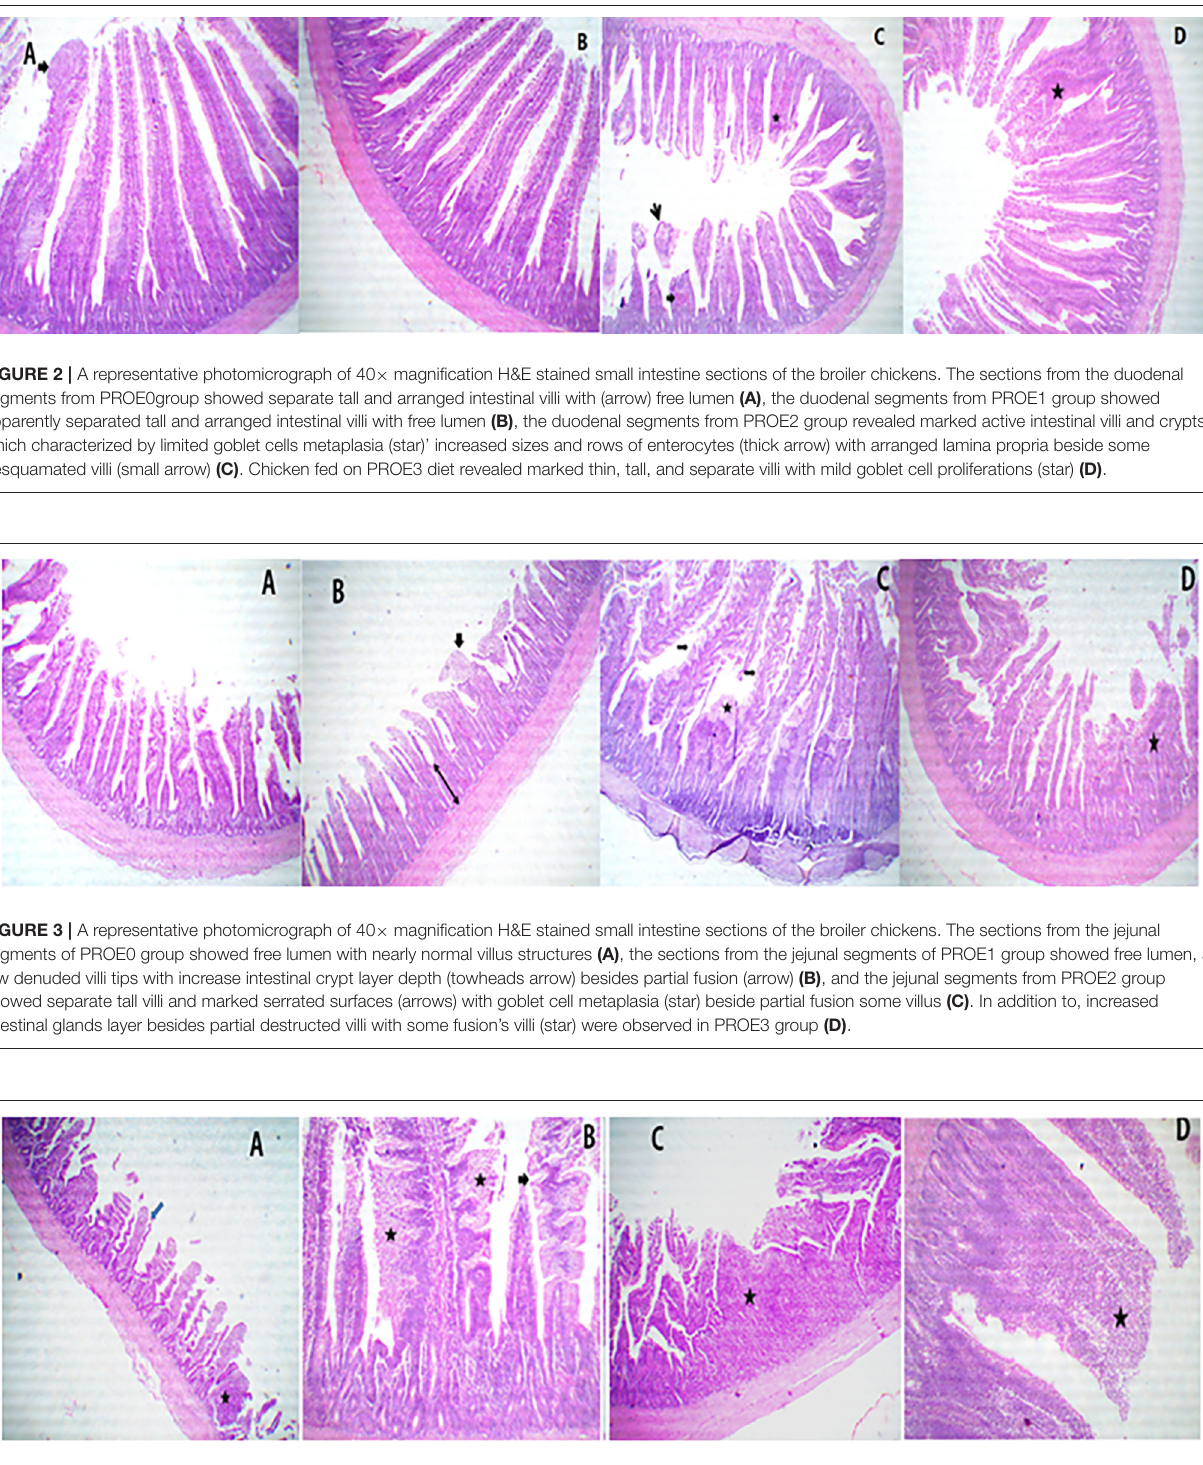
FIGURE 4 | A representative photomicrograph of 40 × magnification H&E stained small intestine sections of the broiler chickens. The sections from the ileal segments of PROE0 group showed free lumen and nearly normal limit gut associated lymphoid follicles (star) with a few denuded villi (arrow) (A) , the sections from ileal segments of PROE1 group showed thickened and serrated (arrow) of villi due to enterocytes and goblet cell metaplasia (stars) with narrowing of the lamina propria (B) . The sections from PROE2 group showed marked hyperplastic intestinal gut associated lymphoid follicles (star) (C) . The sections from PROE3 showed marked fusion villi due to increase enterocytes proliferations and goblet cells metaplasia (star) (D)